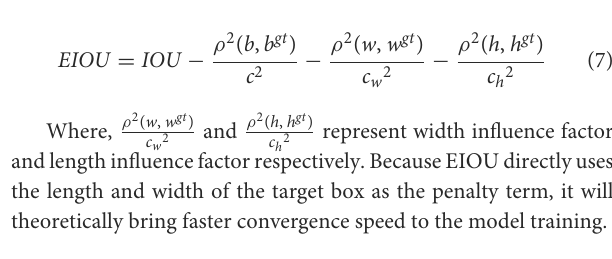
distance square of the maximum circumscribed matrix between the prediction box and the truth box. β is the aspect ratio influence factor, and v represents the penalty items of the prediction box and the truth box. It can be seen from the formula that CIOU takes into account the center distance, area overlap, and aspect ratio of the prediction box and the truth box. Compared with ordinary IOU, it can more effectively reflect the similarity of the target box.